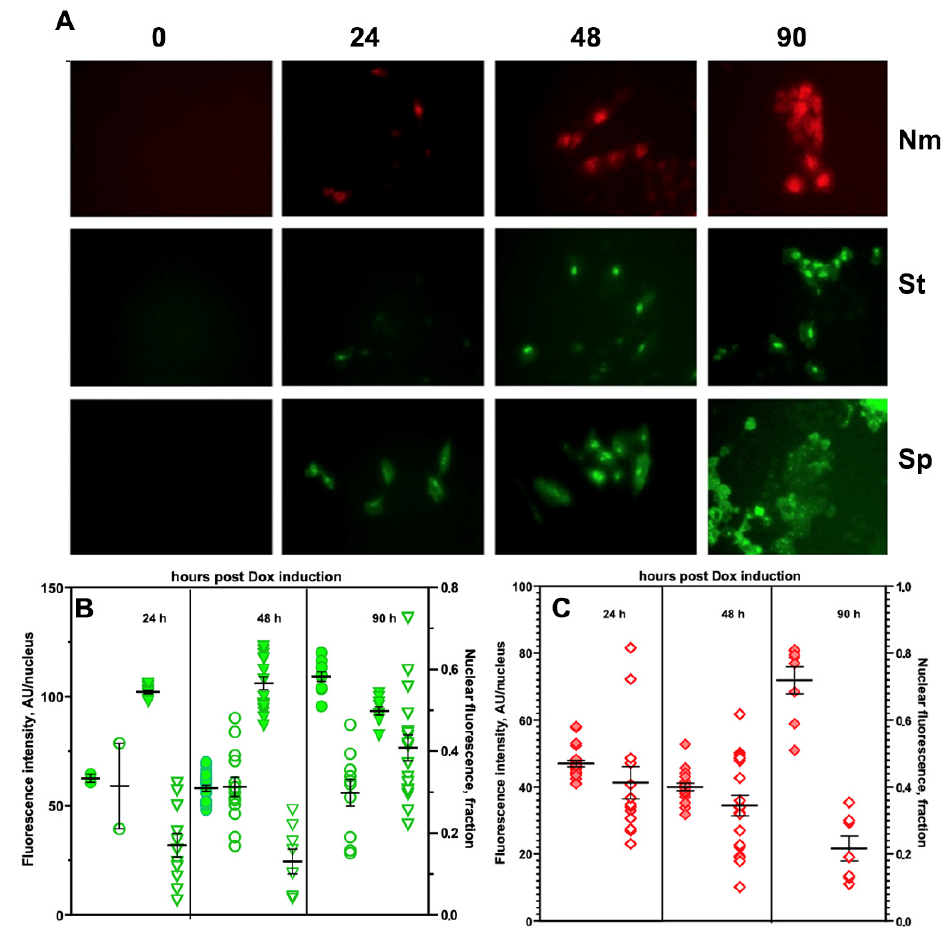
Figure 1. Tet-On-induced expression of chimeras by doxycycline (2 µg/mL) at 0 h, 24 h, 48 h and 90 h post induction. ( A ) Fluorescence microscopy of dCas9-FP chimeras expressed in A549 cells: (1) NmdCas9-mCherry (top row); (2) StdCas9-EGFP (middle row) and (3) SpdCas9-EGFP (bottom row) after Dox-induced expression. EGFP fluorescence: Ex. BP 470/40, BS FT 495/ Em. BP 525/50; mCherry fluorescence: Ex. BP550/25 BS FT 570/Em. BP 605/70 (Zeiss Axio Observer, X40). ( B ) Green FI dependence in cell nuclei due to expression of StdCas9-EGFP ( ) or SpdCas9-EGFP ( ) A549 cells, as well as the fraction of total fluorescence in cell nuclei after the induction ( , ); ( C ) the dependence of red FI of cell nuclei ( ) due to expression of NmdCas9-mCherry and the fraction of total FI of the cell nuclei ( ) after the induction of chimera expression by Dox.